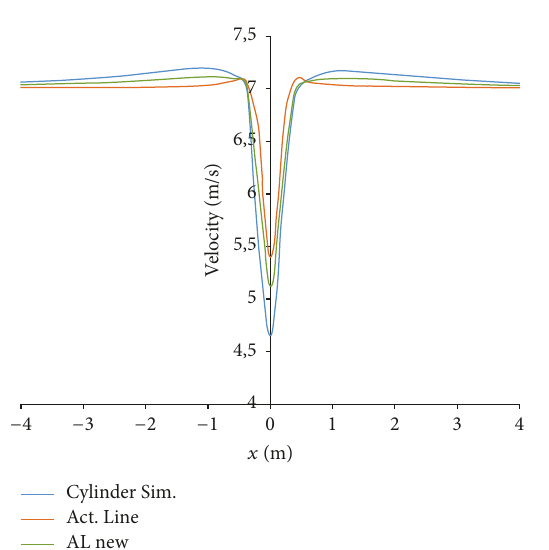
Cylinder Sim. Act. Line Figure 4: Comparison of the velocity drop at 1.4m behind the tower for cylinder and actuator line simulations.